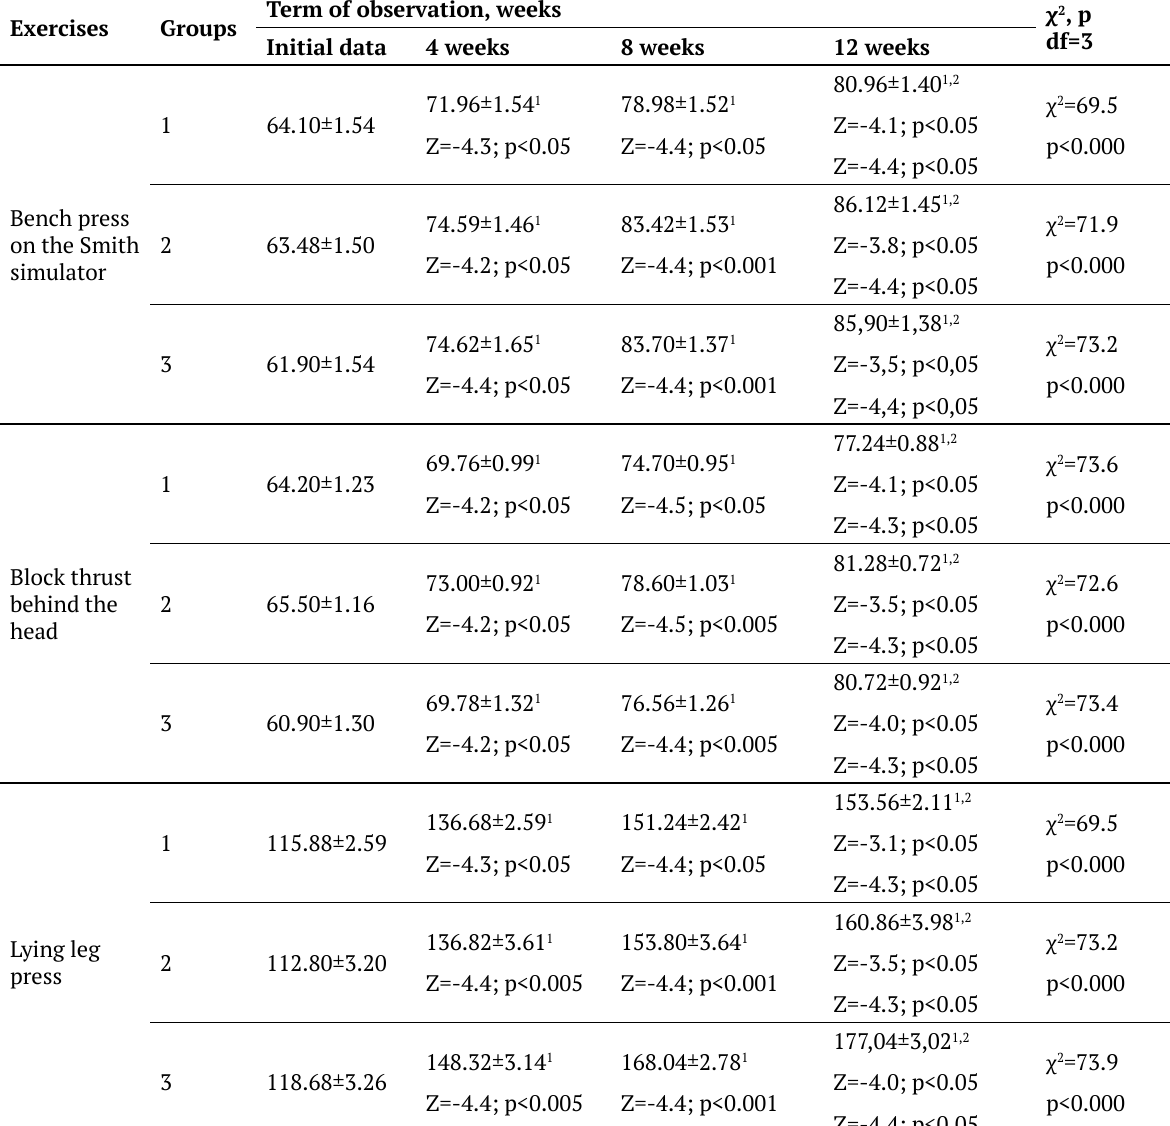
Table 2. Changes in strength capabilities (1RM) results in study participants during 12 weeks of research,